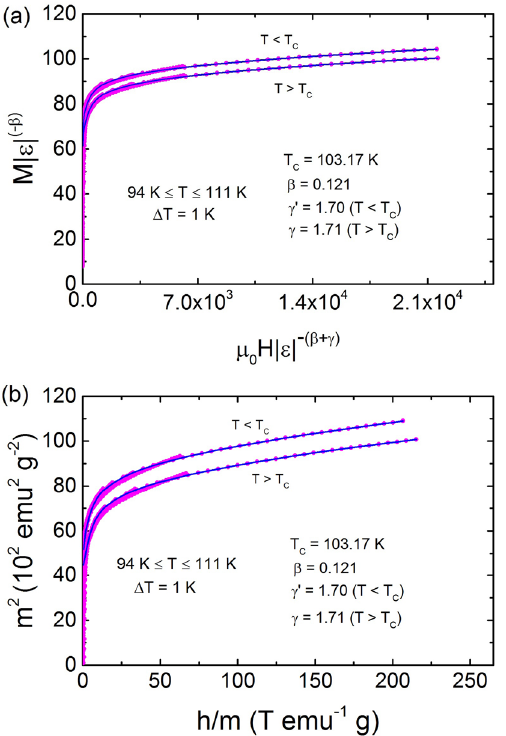
Figure 8. ( a ) Scaling of the M–H curve below and above T C for TL-LSMO-0.3 in critical region ǫ ≤ 0.1 using Eq. (12). Solid lines show best fit polynomials. Collapse of all the M–H curve on single curve below and above T C separately confirms the validity of obtained exponents. ( b ) m 2 vs h/m below and above T C also shows collapse of curve again validate the obtained results. (Figures have been drawn using OriginPro 2015